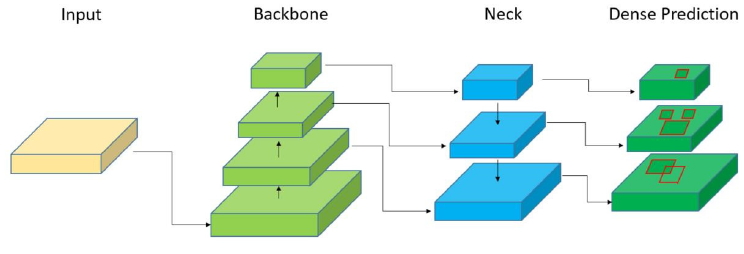
Figure 1. The architecture of one-stage detector.